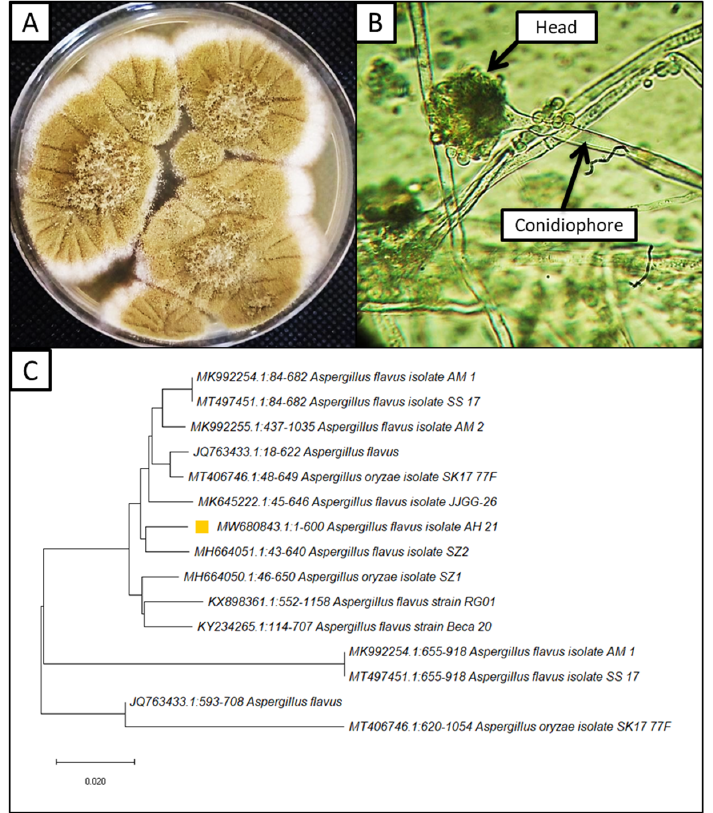
Figure 1. Morphological and molecular identification of A. flavus ( A – C ); ( A ) surface of culture on PDA media; ( B ) conidiophores and head under the light microscope (400×); ( C ) phylogenetic tree PDA media; ( B ) conidiophores and head under the light microscope (400 × ); ( C ) phylogenetic tree for for A. flavus (orange square). A. flavus (orange